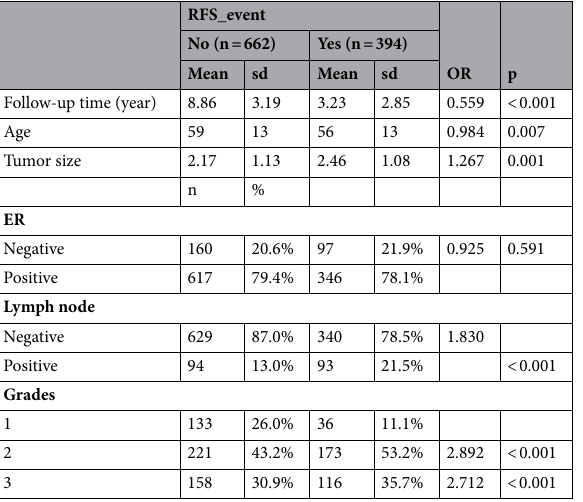
Table 1. The clinical characteristics of BC patients of validation data sets. RFS relapse-free survival, ER estrogen receptor, sd standard deviation. Odds ratio (OR) and p values are analyzed using univariable logistic regression.